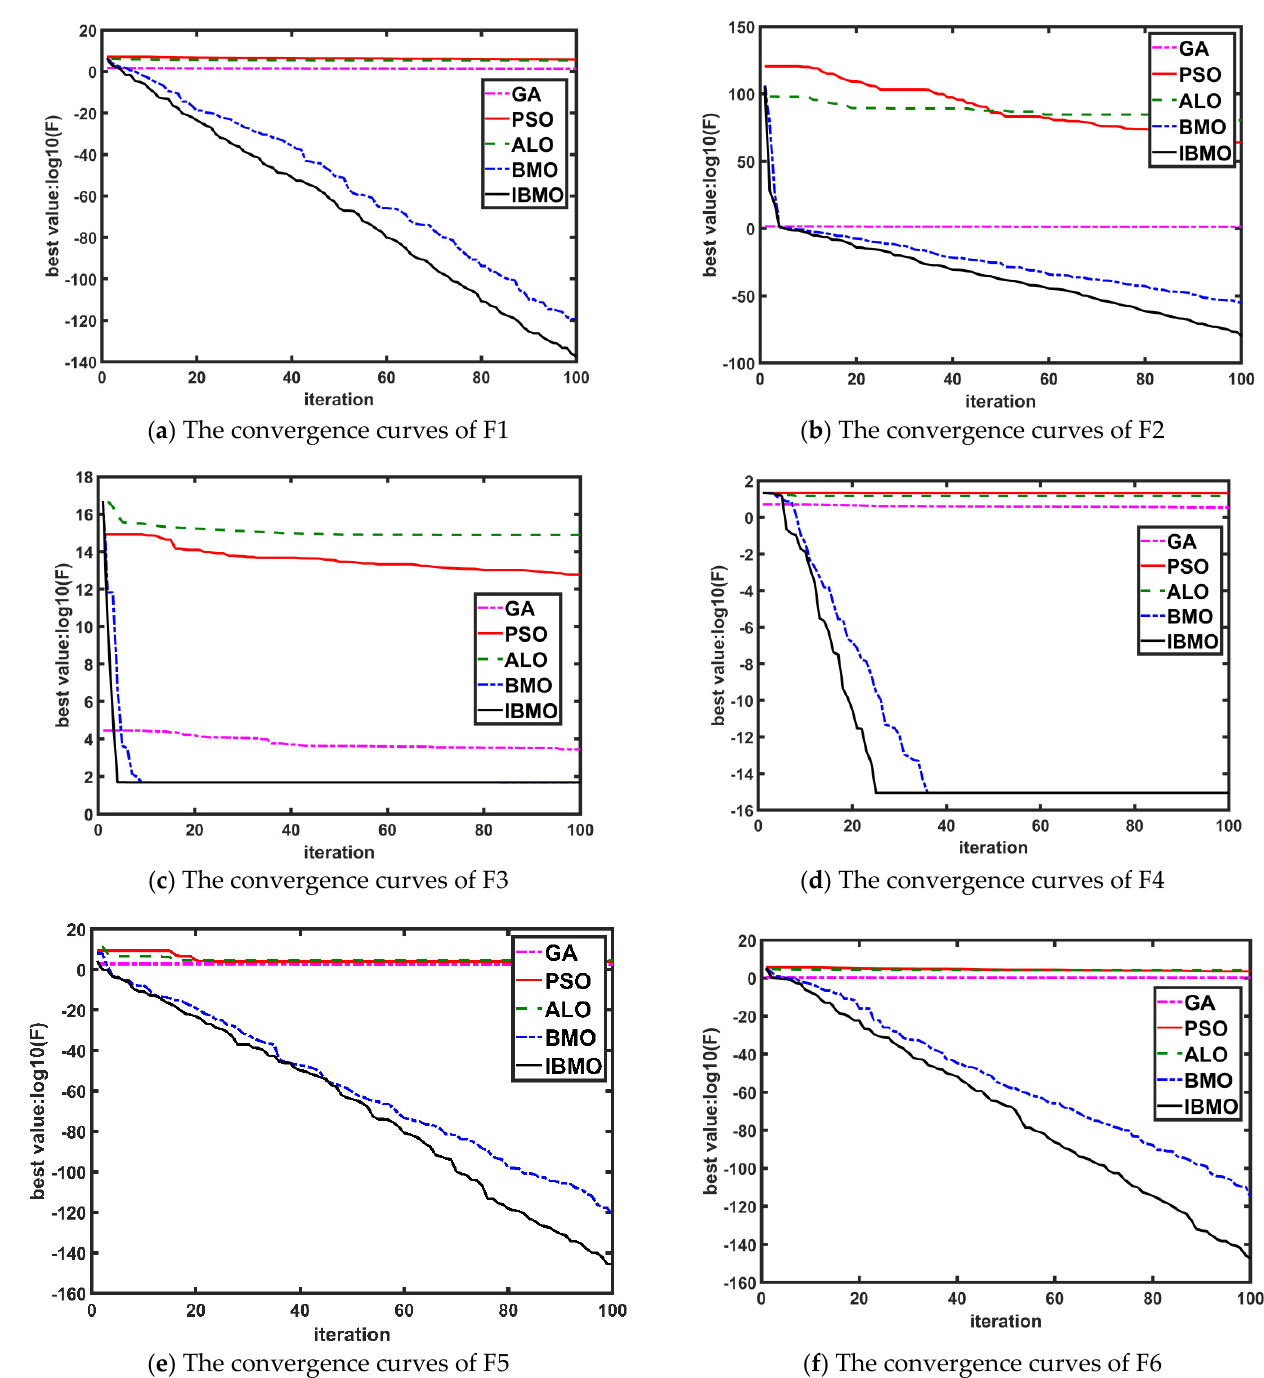
Figure 2. Comparison of convergence curves of F1–F6 functions. ( a )–( f ) correspond to the convergence curves of F1 to F6 respectively.